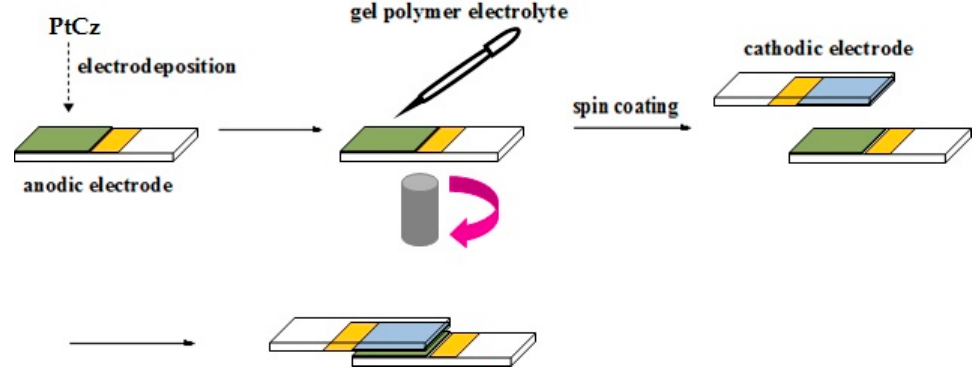
Figure 1. The fabrication procedures of electrochromic devices (ECDs).